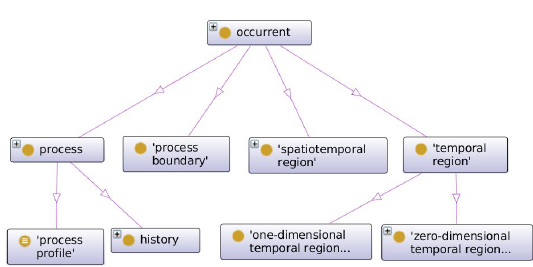
Figure 3. Hierarchy of occurents on the example of